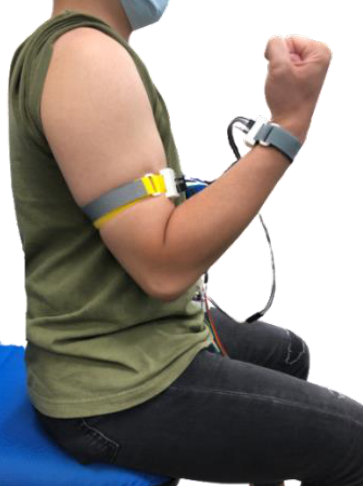
Figure 7. Measurement scenarios of the ROMSS.